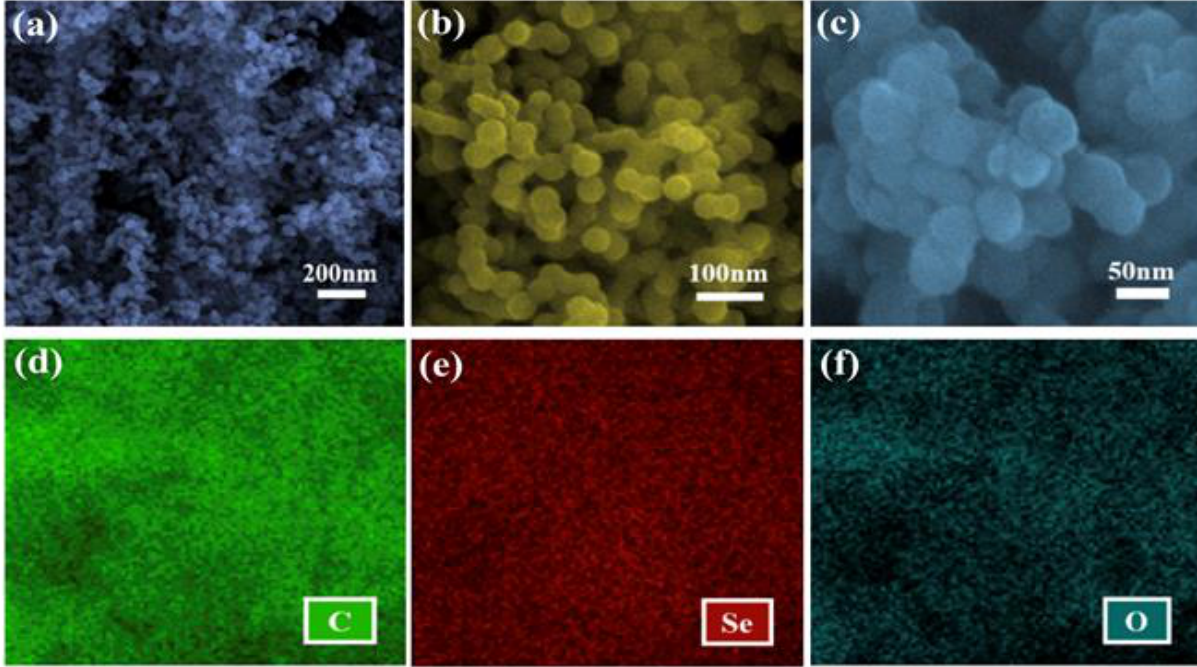
Figure 1. Morphology of bare carbon spheres and CSs@Se composite: ( a , b ) low and high magnification SEM images of bare carbon spheres, ( c ) high magnification surface morphology of CSs@Se composite, ( d – f ) EDS mapping of the CSs@Se showing the presence of carbon (C), selenium (Se), and oxides (O), respectively.